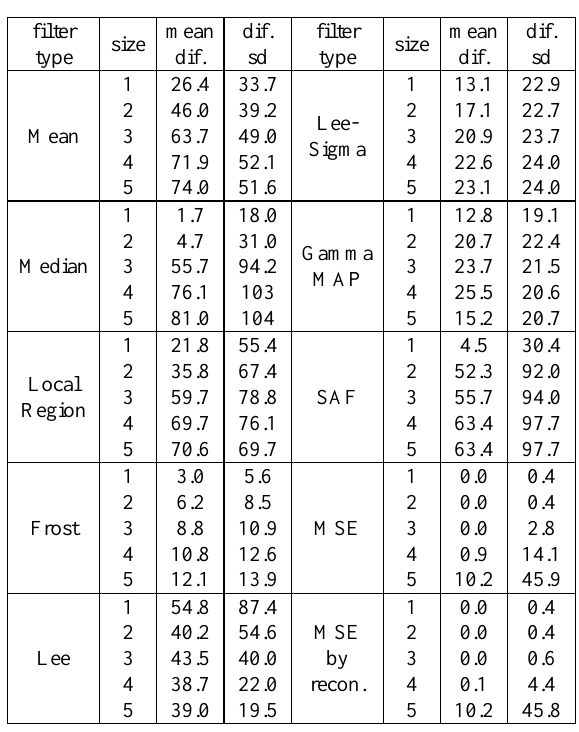
Table 2. Comparison of the results of selected filtration of a simulated speckle-free detailed image to the source reference image; mean dif . is the mean value of the differential image, and dif. sd is its standard deviation